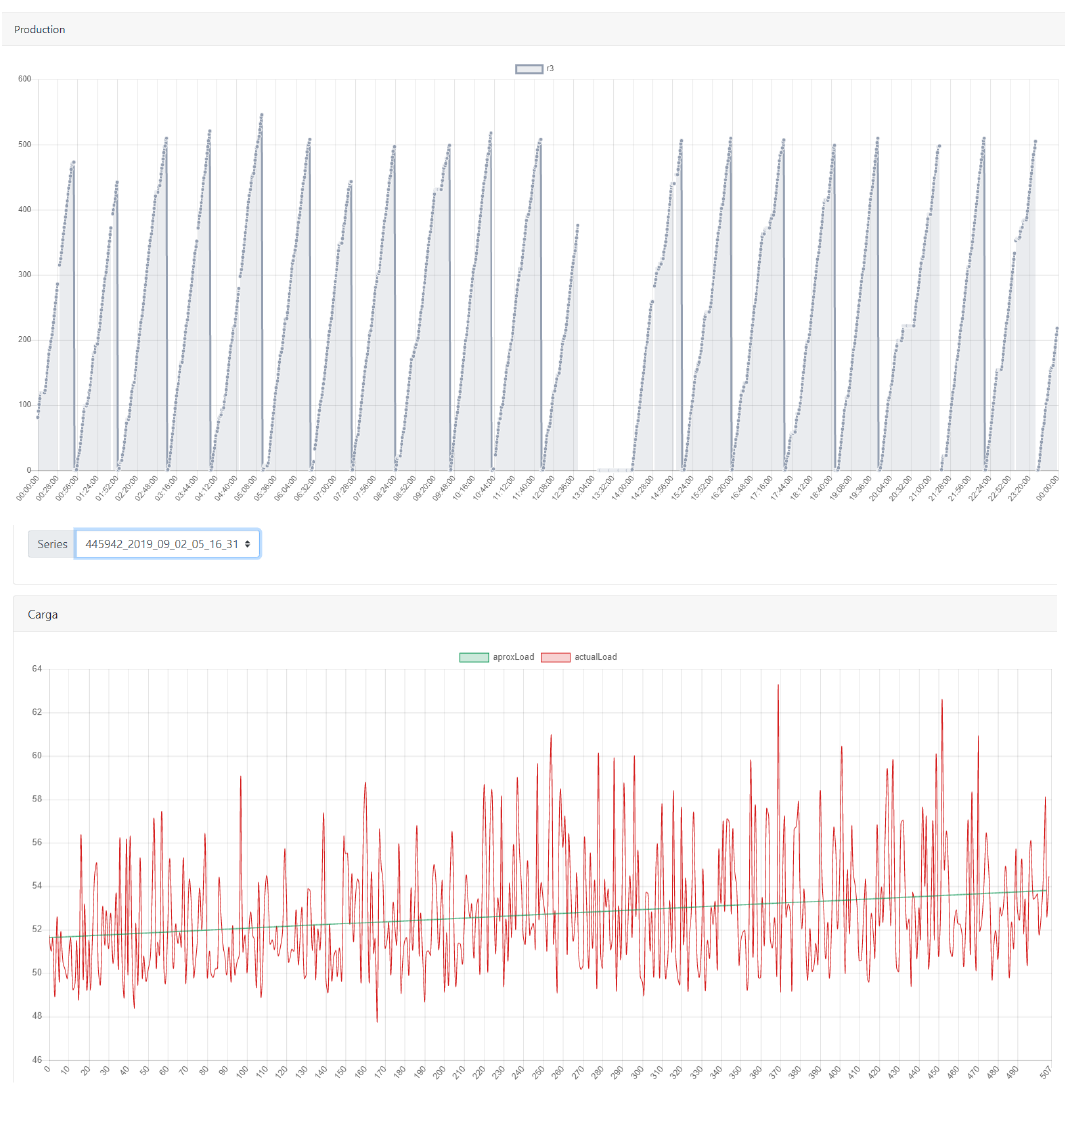
Figure 5. Application integrated at the machine showing the Remaining Useful Life (RUL) for the actual working